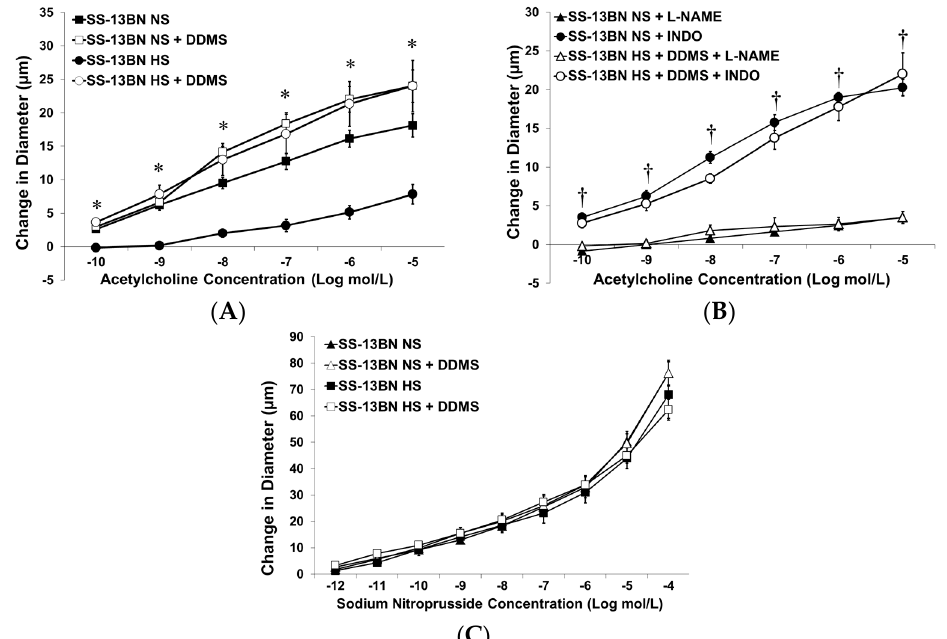
Figure 1. Response of isolated middle cerebral arteries of SS-13 BN consomic rats fed normal-salt (NS) diet or high-salt (HS) diet to: ( A ) acetylcholine (ACh; 10 − 10 –10 − 5 M) ± acute addition of 50 µM DDMS; ( B ) ACh ± DDMS (50 µM) and ±L-NAME (100 µM) or indomethacin (INDO; 1 µM); and ( C ), sodium 50 µM nitroprusside (10 − 12 –10 − 4 M) ± acute addition of DDMS (50 µM) to the tissue bath. Data are expressed as mean change in diameter (µm) from baseline ± SEM and n = 4–8 for all groups. Signif- icant di ff erence: * p < 0.05 vs. arteries from HS-fed SS-13 BN consomic rats, † p < 0.05 vs. L-NAME- treated vessels.